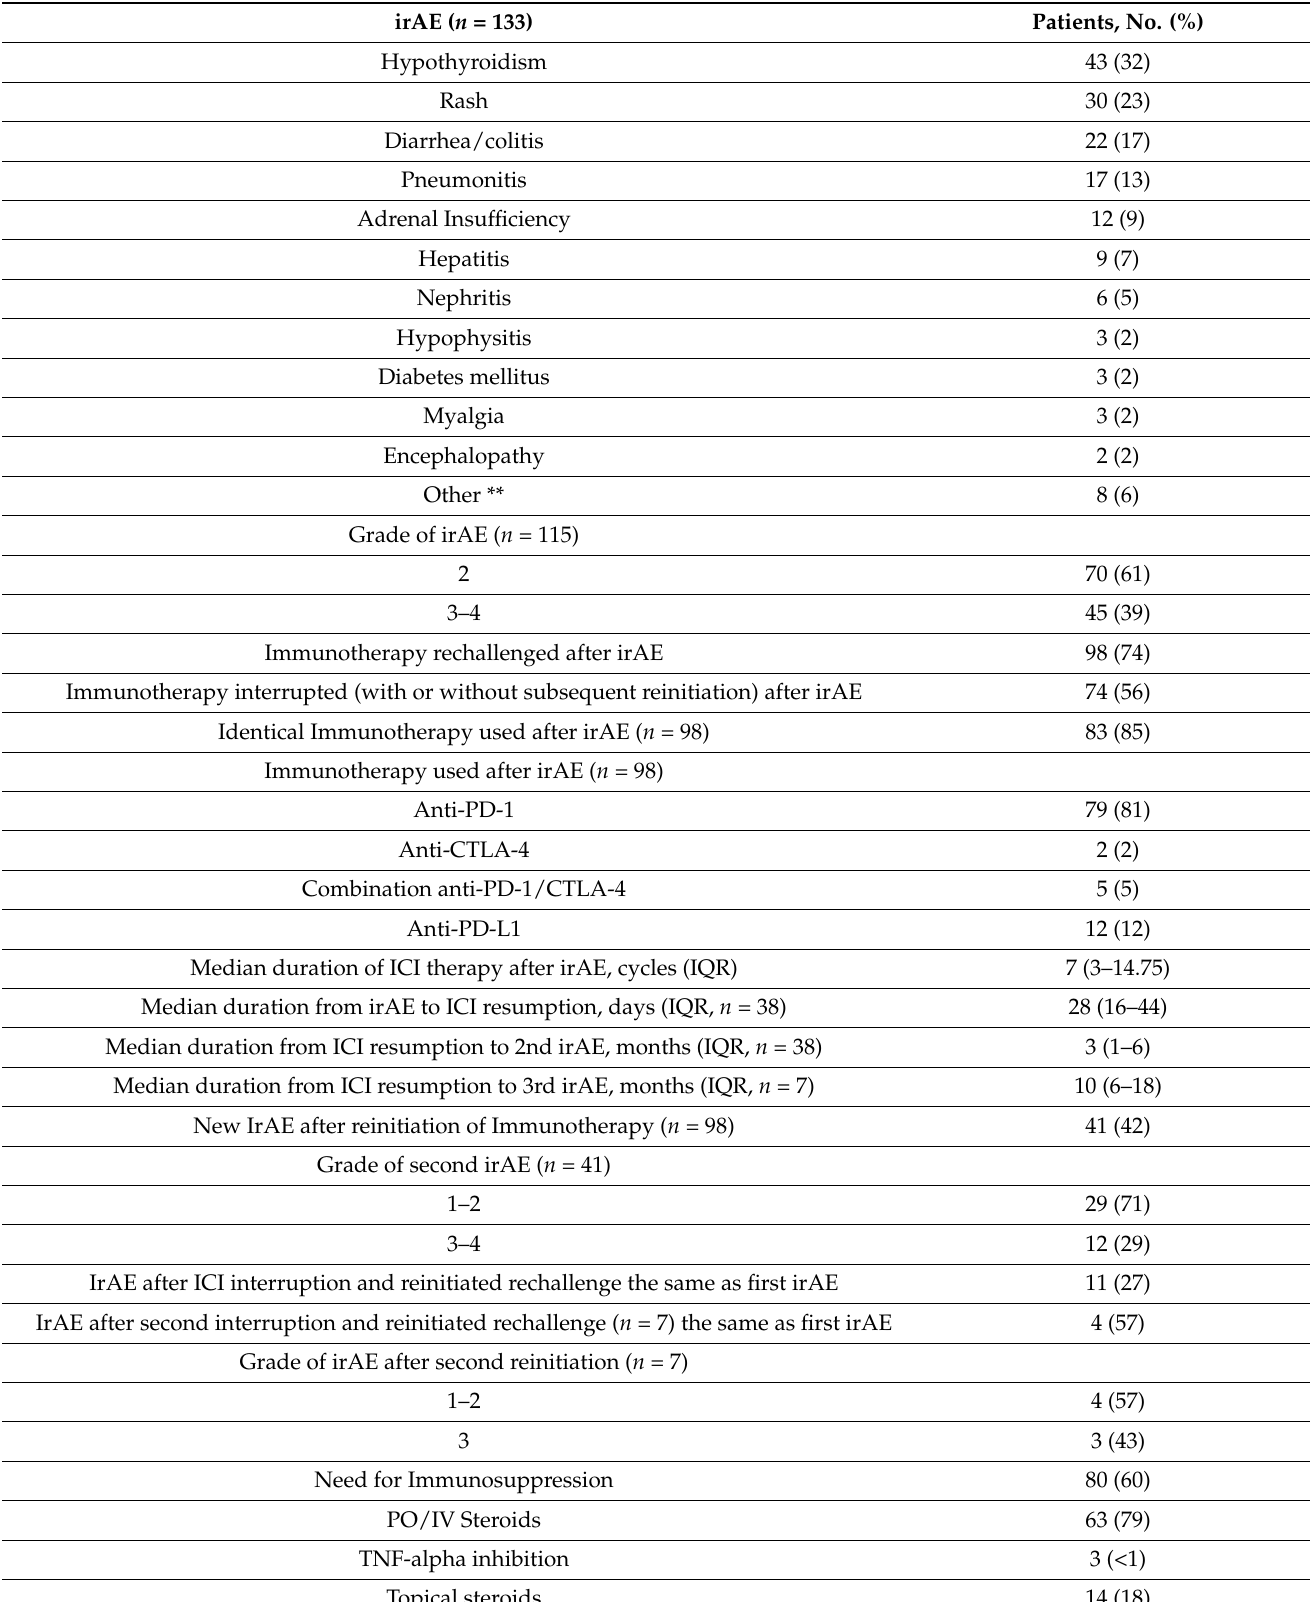
Table 2. Characteristics of Initial and Sequential